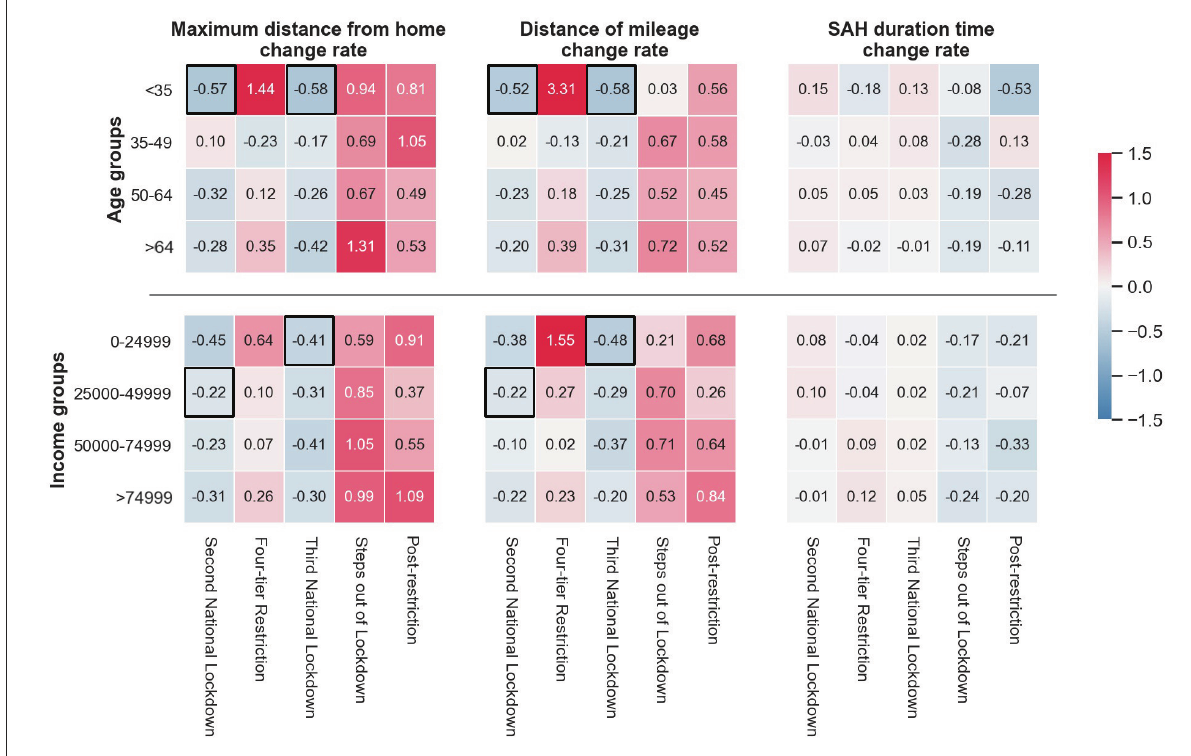
FIGURE5 The change rates of mobility indicators in age and income groups during the six restriction periods. The red grids denote increases in change rate ( > 0), and the blue ones represent reductions in change rate ( < 0), with colour saturation indicating the change rate level. The black boxes highlight the grids for (1) The biggest change rates (absolute values) in “Second National Lockdown” and “Third National Lockdown”; (2) The KWH results show the indicators are significantly different between the current period and the former